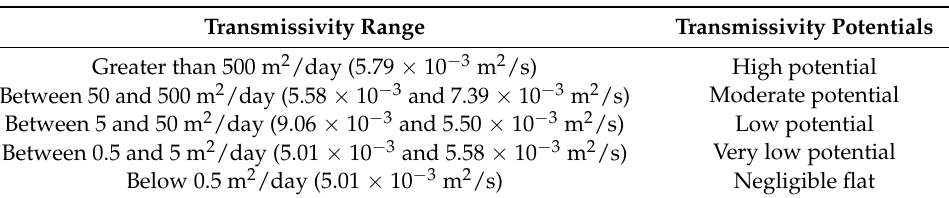
Table 3. Gheorghe standard for transmissivity ( T ) [27].